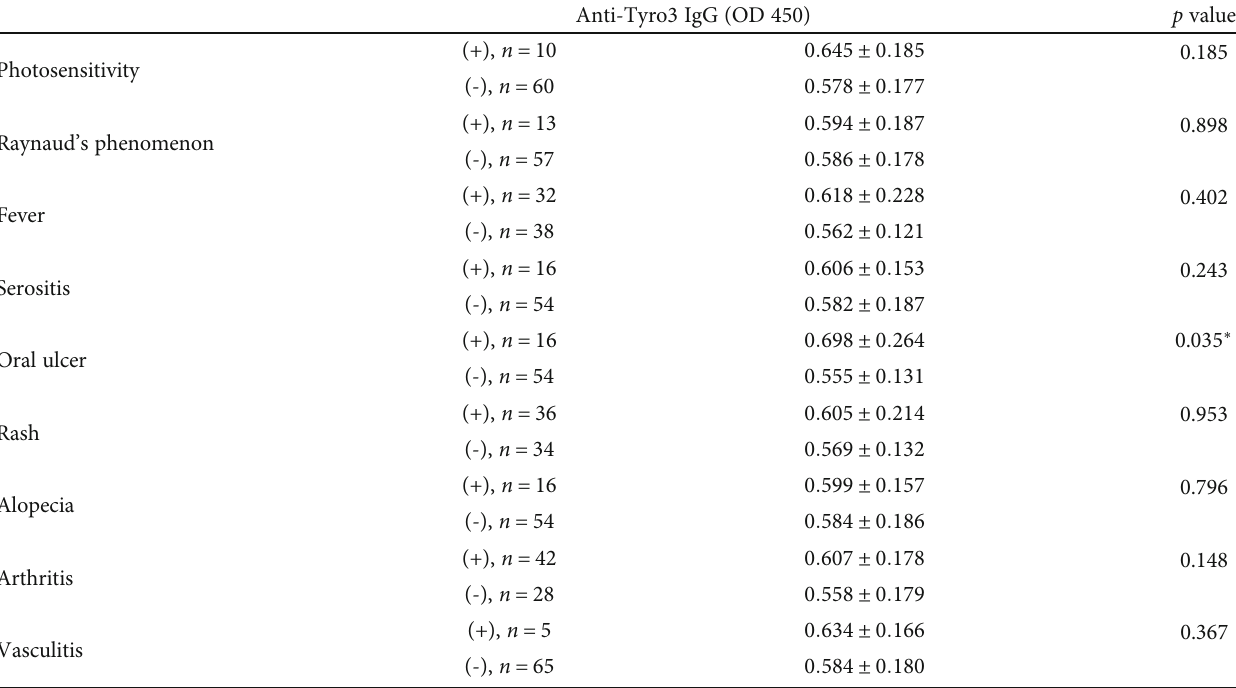
Table 2: Comparison of anti-Tyro3 antibody according to disease manifestations in 70 new-onset and treatment-naïve SLE patients.